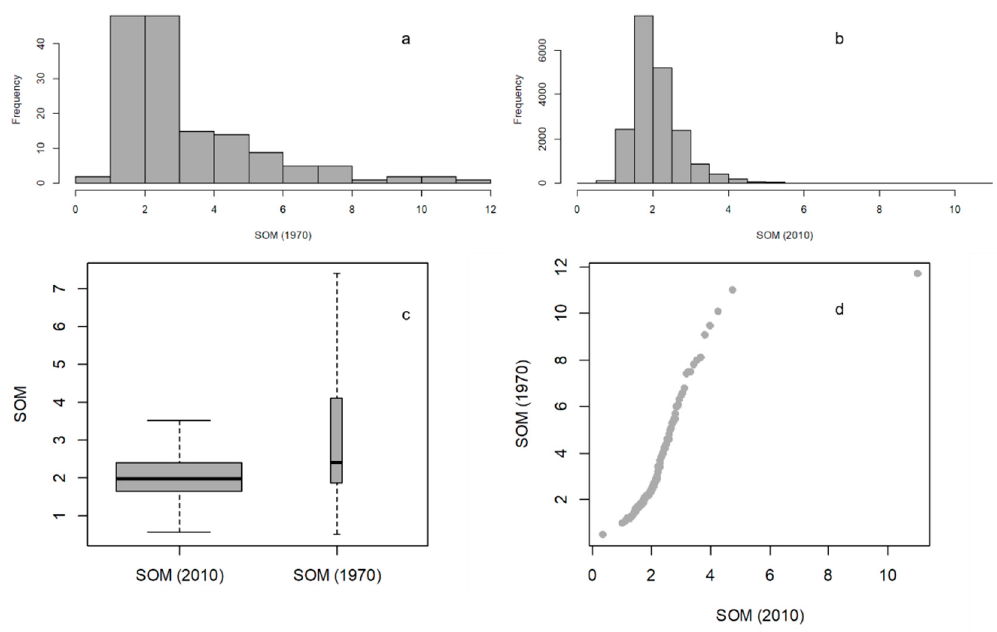
Figure 3. Frequency distributions of SOM2010 ( a ) and SOM1970 ( b ) datasets, and their box-plots ( c ) and Q-Q plots ( d ).